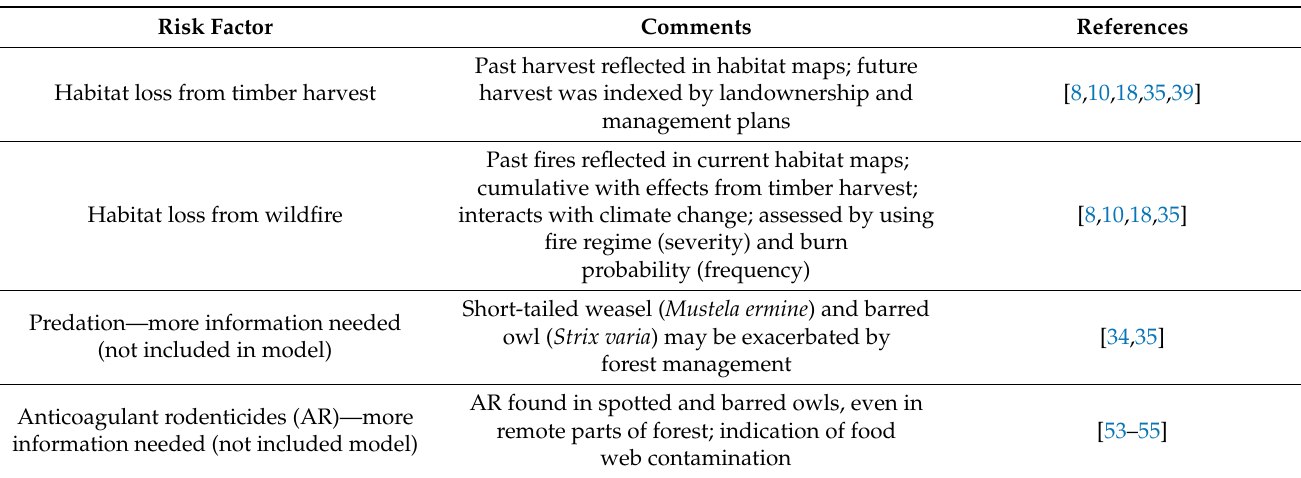
Table 2. Summary of information on factors that pose risks or potential risks to the viability of red tree voles ( Arborimus longicaudus ) in the evaluation area in Oregon and California, USA. Risk